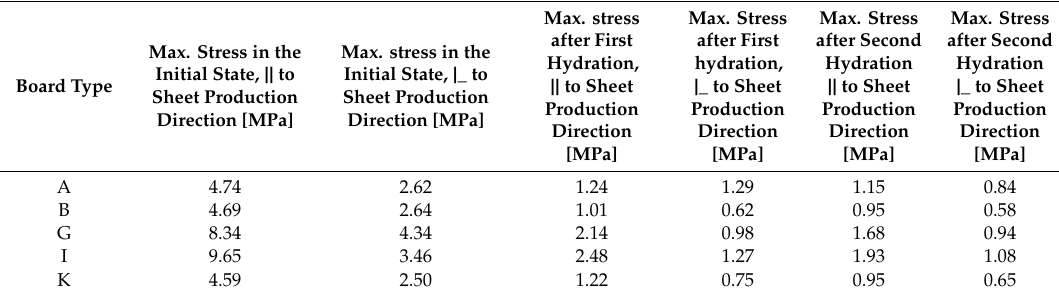
Table 4. Results of the mechanical tests performed on investigated plasterboard